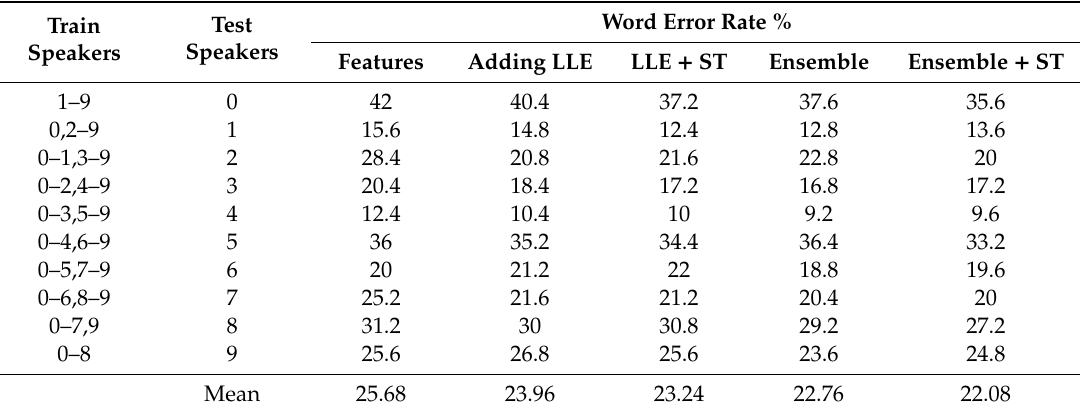
Table 5. Word Error Rate for 10% data as